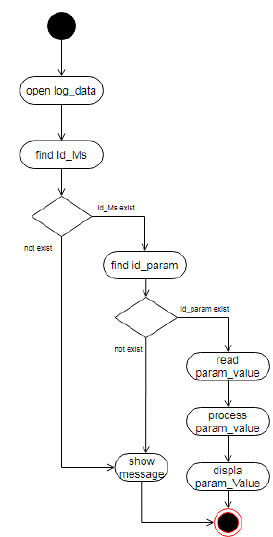
Figure 7. Activity diagram for process check endpoint